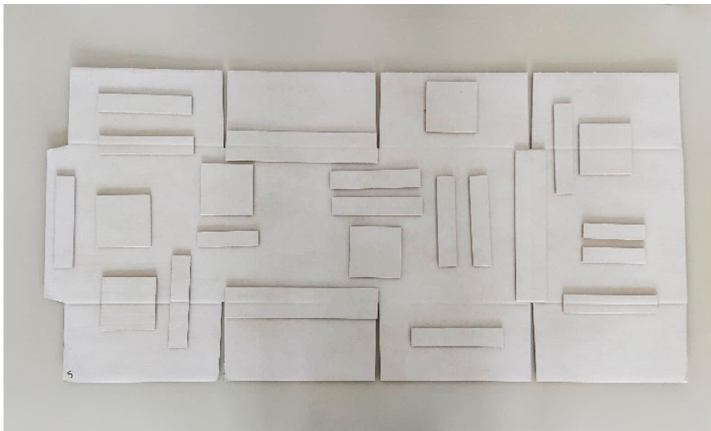
Figure 6. The box considered in this study before folding, with positions of carboard samples cut for tests.